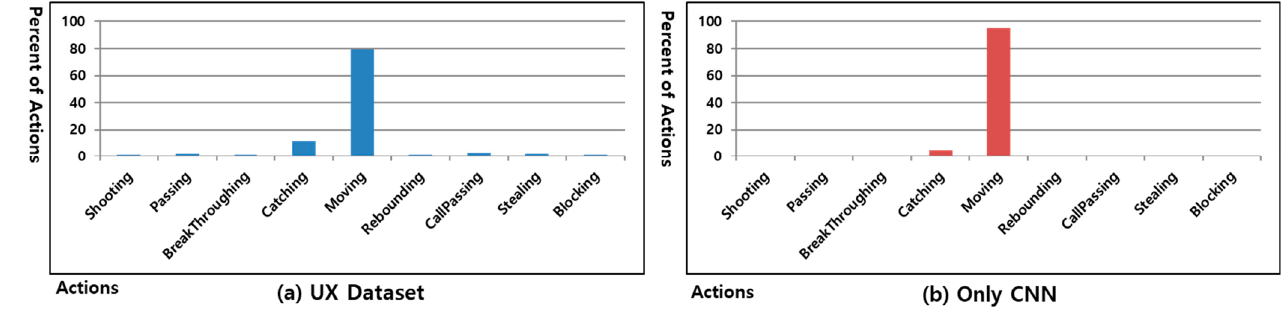
Figure 7. Percent of actions in UX dataset of user #1 and using only CNN in the Freestyle game.